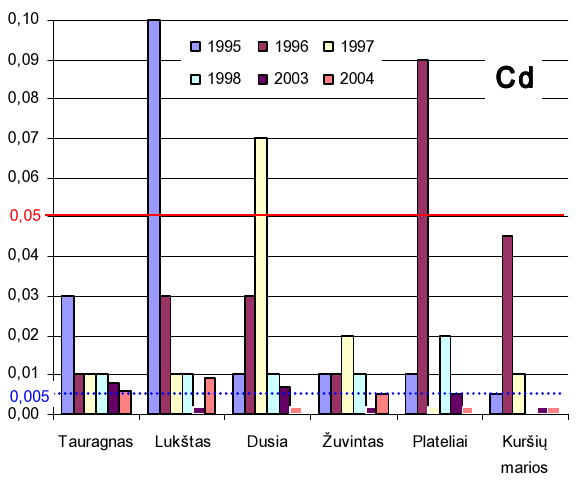
Fig. 13. Heavy metal concentrations (mg/kg) in fish tissu- es from water contaminated with cadmium in 2006